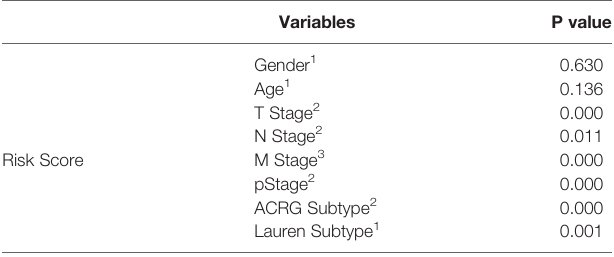
TABLE 2 | The relationships between the risk score and clinical